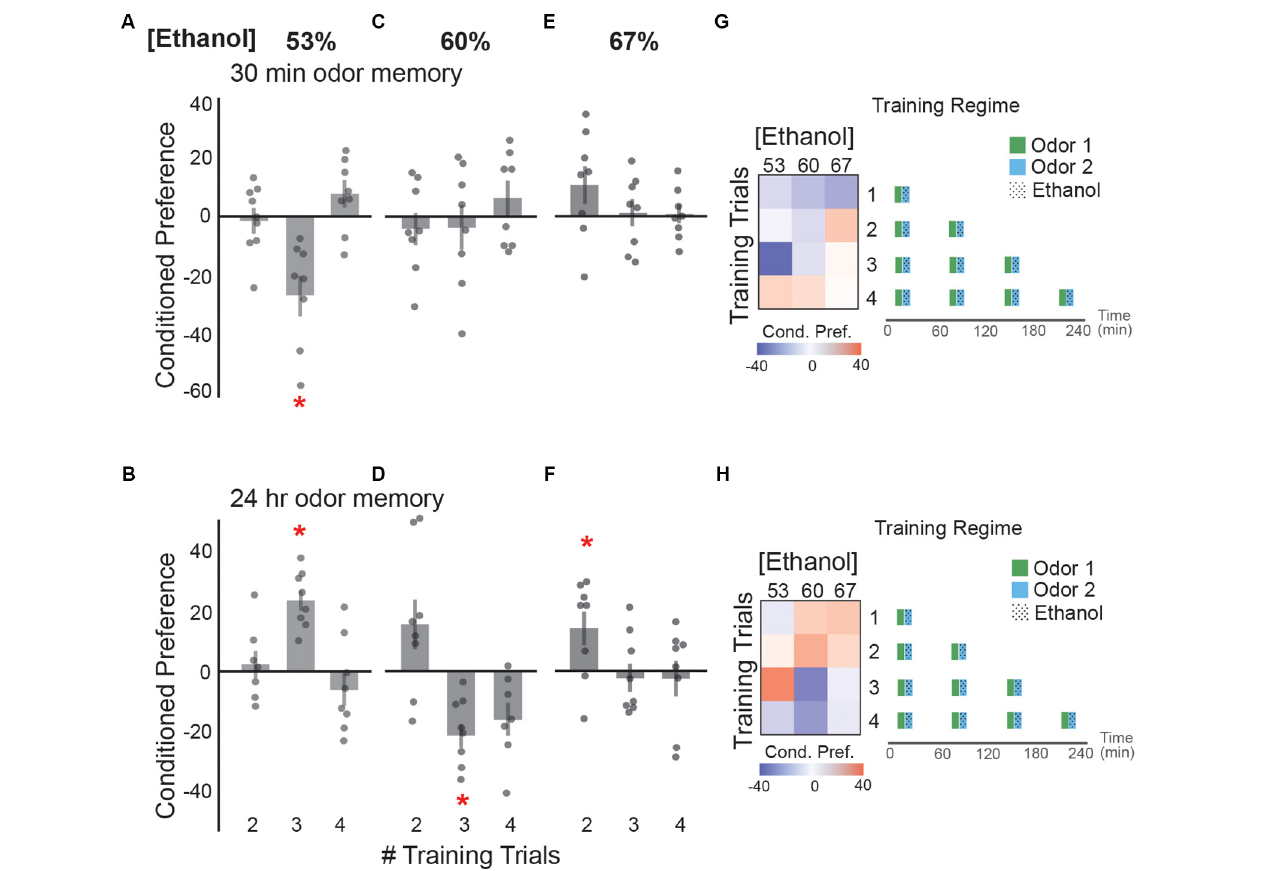
FIGURE 4 | Preferences following spaced training depend on ethanol dose. (A) Three spaced training sessions of 53% ethanol concentration resulted in a significant aversive preference at 30 min [ t (13.45) = 3.57, p = 0.003]. (B) The same training conditions induced a significant appetitive preference when tested at 24 h [ t (12.58) = − 6.57, p = 0.0001]. (C) Spaced training sessions with 60% ethanol concentration do not induce a preference at 30 min, but (D) result in a trend toward an appetitive memory after two trials [ t (11.79) = − 0.83, p = 0.09] and an aversive memory after three trials [ t (11.86) = 3.92, p = 0.002] at 24 h post- training. (E) Spaced sessions with 67% ethanol concentration do not induce significant preference at 30 min, but (F) result in an appetitive ethanol preference after two trials [ t (13.05) = − 2.49, p = 0.03] at 24 h post-training. (G) Heat maps summarizing the 30 min preference relationships with training trial number and ethanol concentration suggest a complex dose relationship where an increase in the number of training trials and dose of ethanol trends towards a switch from appetitive (red) to aversive (blue) memory. Schematic of the training paradigms are depicted. (H) Inversely, heat maps displaying the preference trends at 24 h suggest that an increase in the number of training trials and dose of ethanol trends towards a switch from appetitive (red) to aversive (blue) memory. Bars represent mean +/ − standard error. N ∼ 8 per group where individual data points represent N = 1 ( ∼ 100 flies) CPI. ∗ p < 0.05.